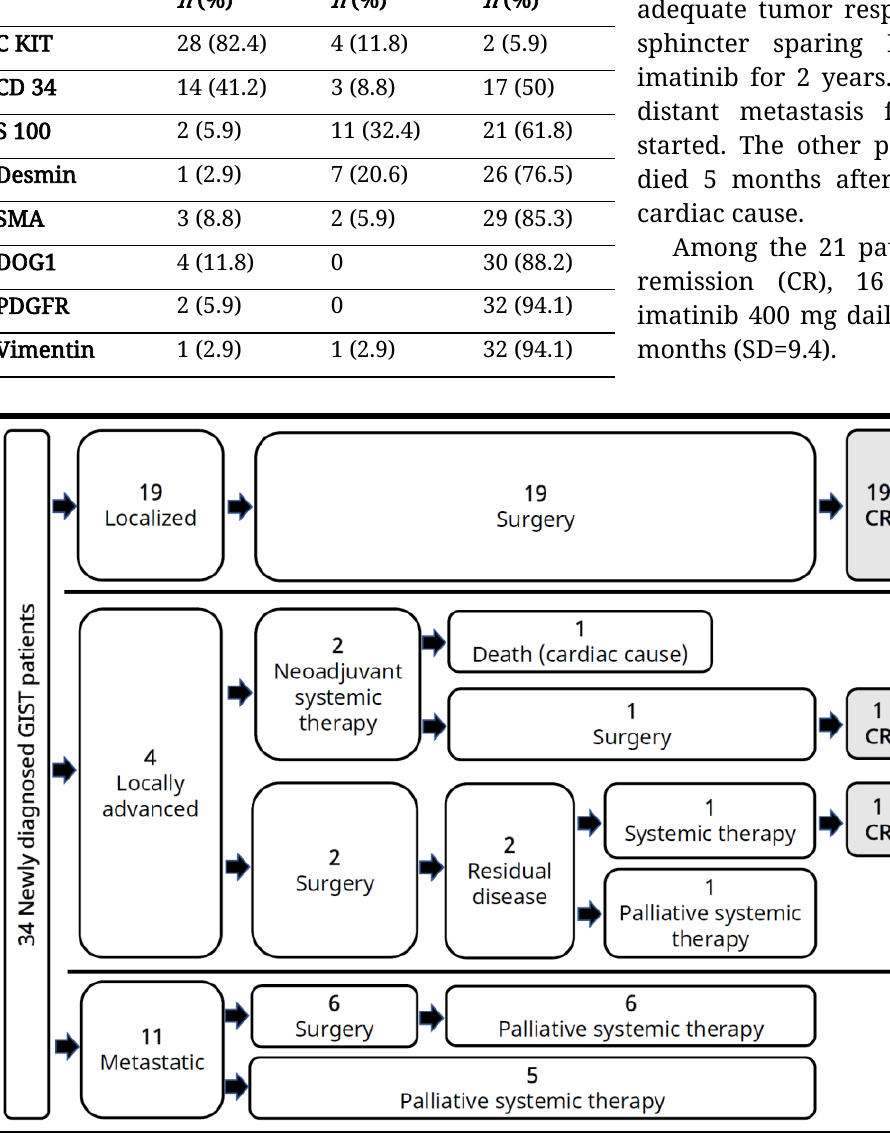
Figure 1: Summary of the management of 34 patients with GIST in different stages Patients were followed up for a median duration of 38.9 months (95%CI: 32.9 – 56.8). The mean overall survival of the whole group of patients was 84.5 months (95%CI: 67.2 – 101.8) and the median was not reached. The median OS for patients with localized disease was not reached and for those with locally advanced/metastatic disease it was